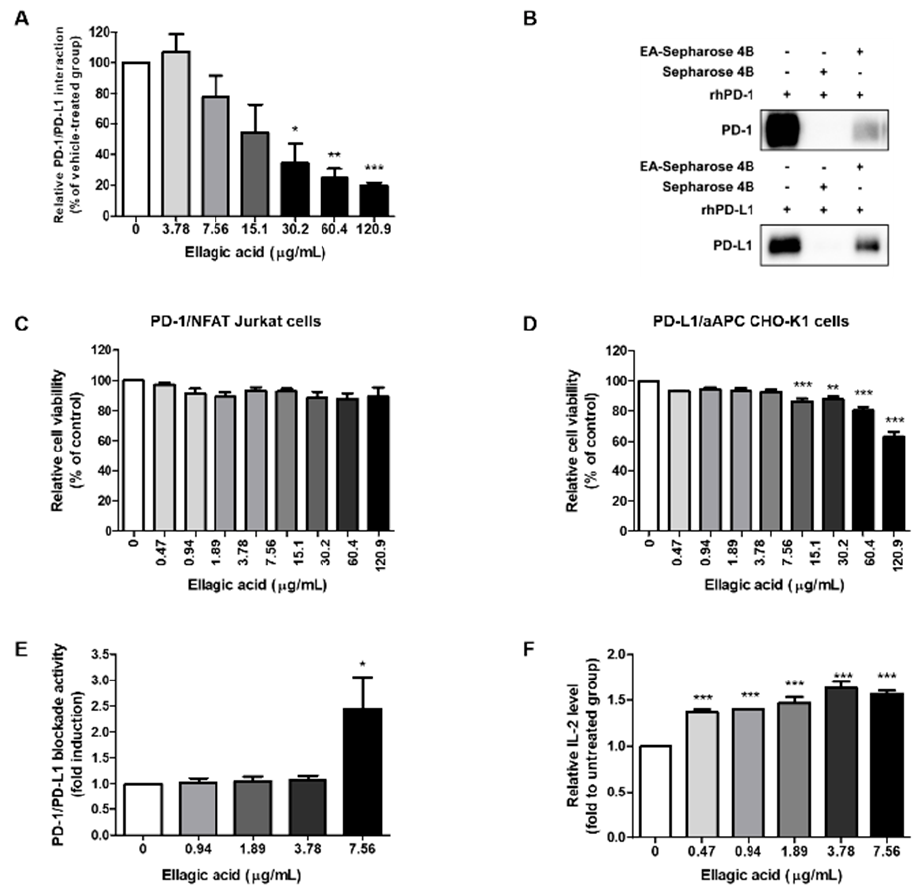
Figure 4. Effect of ellagic acid on PD-1/PD-L1 interaction in vitro. ( A ) Effect of ellagic acid on PD- 1/PD-L1 interaction was measured by competitive ELISA. Ellagic acid was treated as indicated concentration (0–120.9 μ g/mL). ( B ) Ellagic acid binds to PD-1 and PD-L1. Pull-down assays were performed to detect the binding of ellagic acid with PD-1 or PD-L1. Binding by ellagic acid between human recombinant PD-1 or PD-L1 proteins were confirmed by Western blot using antibodies against PD-1 (upper panel) or PD-L1 (lower panel). Lane 1: Recombinant PD-1 or PD-L1 protein alone; lane 2: each of the proteins were precipitated with Sepharose 4B-alone; lane 3: each of the proteins were precipitated with ellagic acid–Sepharose 4B beads (EA-Sepharose 4B). ( C , D ) Effect of ellagic acid on cell viability of (c) PD-1/NFAT Jurkat cells or ( D ) PD-L1/aAPC PD-L1 CHO-K1 cells. The cell viabilities were analyzed using the Cell Counting Kit-8 (CCK) assay. Cells were treated with or ellagic acid as indicated concentrations (0–120.9 μ g/mL). ( E ) Effect of ellagic acid on cellular PD-1/PD-L1 blockade activity. PD-1/NFAT Jurkat effector cells and PD-L1/aAPC CHO-K1 target cells were co- cultured with ellagic acid for 48 h at the indicated concentrations (0–7.56 μ g/mL). The relative PD- 1/PD-L1 blockade activity were measured by PD-1/NFAT luciferase reporter assay. ( F ) Effect of ellagic acid on IL-2 cytokine release in co-cultured cell model. Cell culture media was analyzed to measure IL-2 level by cytokine ELISA. Data are presented as mean ± S.E. of three representative independent experiments. Asterisks indicate significant inhibition of PD-1/PD-L1 binding activity by each test inhibitor as compared with the vehicle-treated group; *** p < 0.001, ** p < 0.01, * p < 0.05, compared with the vehicle group. 4. Discussion Black raspberry is a polyphenol-rich fruit and has been consumed as foods for human health. In addition, unripen fruits of black raspberry ( R. coreanus ) were used as a traditional medicinal plant for kidney disease [22]. Extract of R. coreanus (RCE) has reported to possess a variety of biological properties including anti-cancer in a number of in vitro and animal studies [23]. Seeram et al., and Wang et al., reported that RCE reduced the cell proliferation and induced the apoptosis in HT-29, HCT-116, Caco-2, and SW480 colon cancer cell [24,25]. Diets containing black raspberry (2.5, 5, or 10% w/w ) during 9- or 33- week attenuated azoxymethane (AOM)-induced carcinogenesis by down- regulation of DNA oxidation levels in rats [26]. Another study by Bi X. et al., also showed that diet